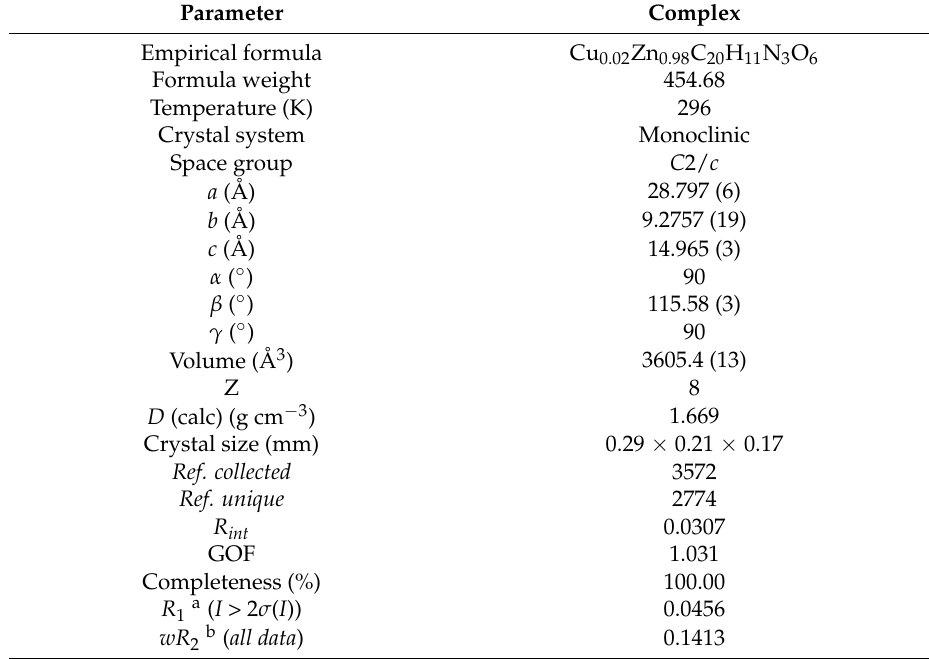
Table 1. Crystallographic data of Complex.